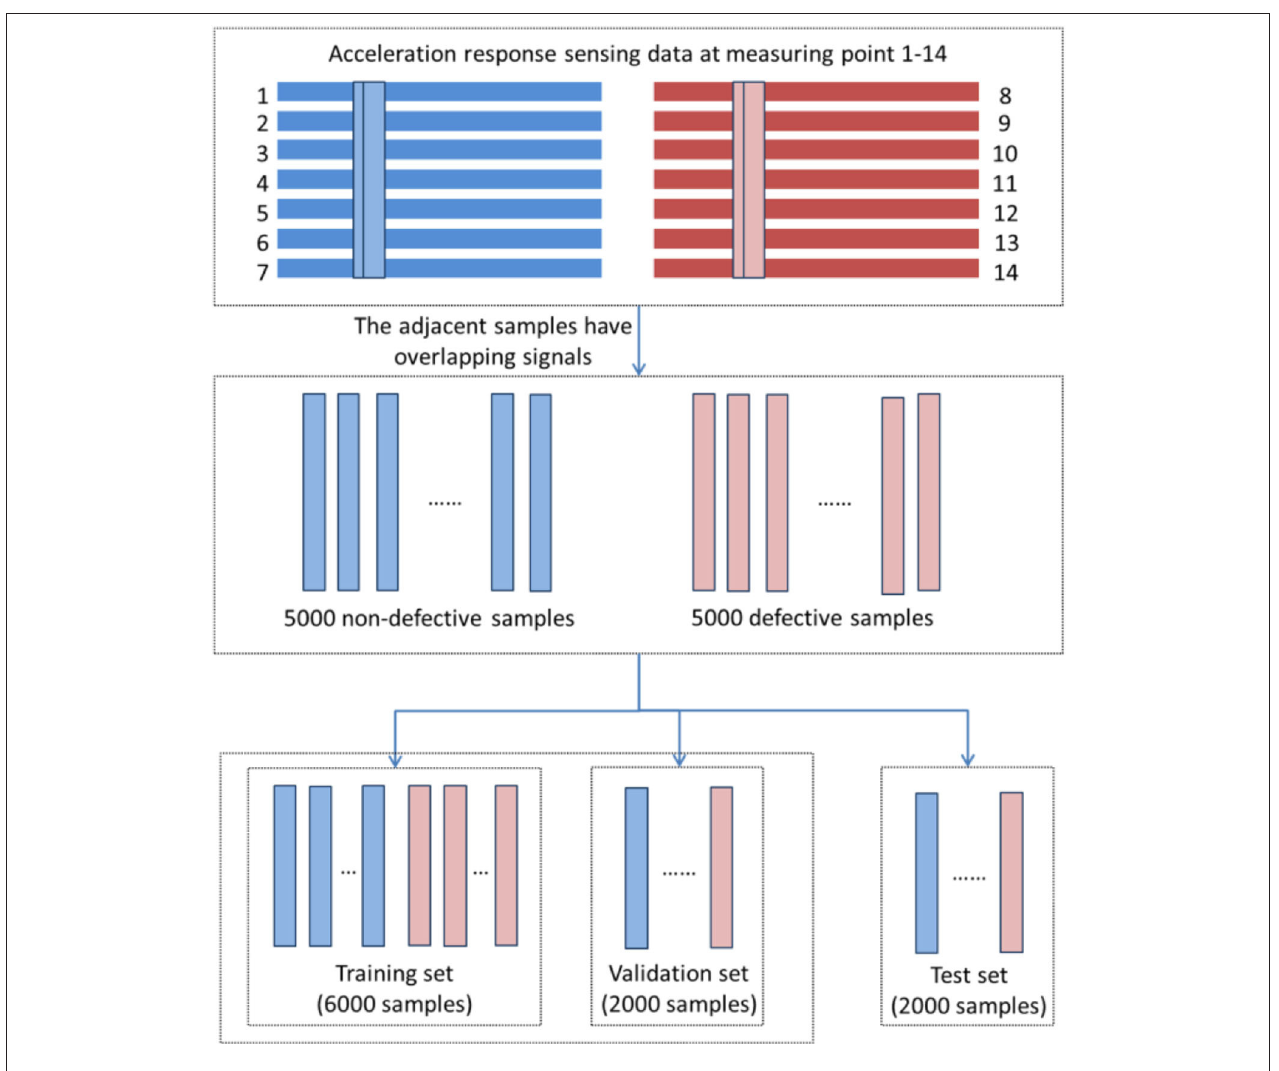
FIGURE 11 | The creation of datasets.